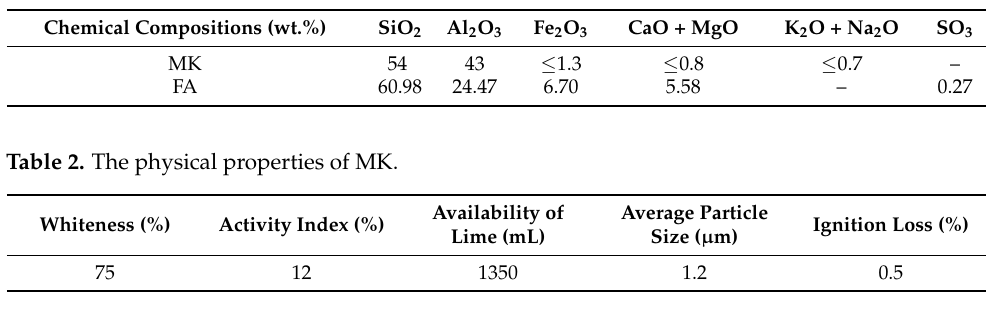
Table 3. The physical properties of FA.